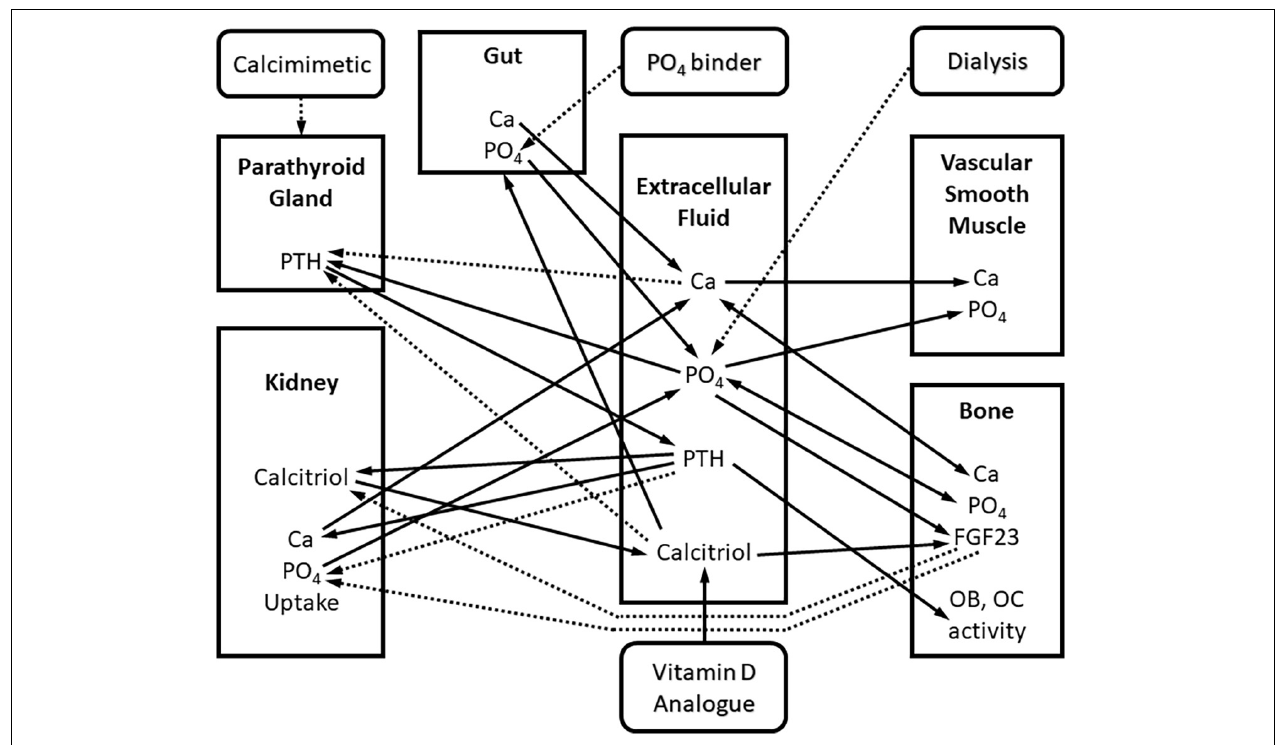
FIGURE 1 | Block diagram of the quantitative systems pharmacology model of Ca and PO 4 metabolism in chronic kidney disease. Square blocks represent compartments, rounded blocks represent interventions. Arrows represent interactions between biomarkers and compartments: continuous – positive interaction, dashed – negative interaction. Interactions are mathematically described using ordinary differential equations